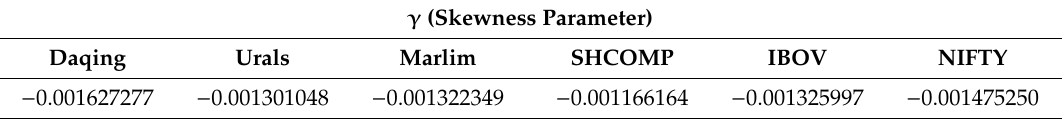
Table A4. MNIG Skewness parameter γ for Vector 1: Daqing, Urals, Marlim, SHCOMP, IBOV, NIFTY. γ (Skewness Parameter)